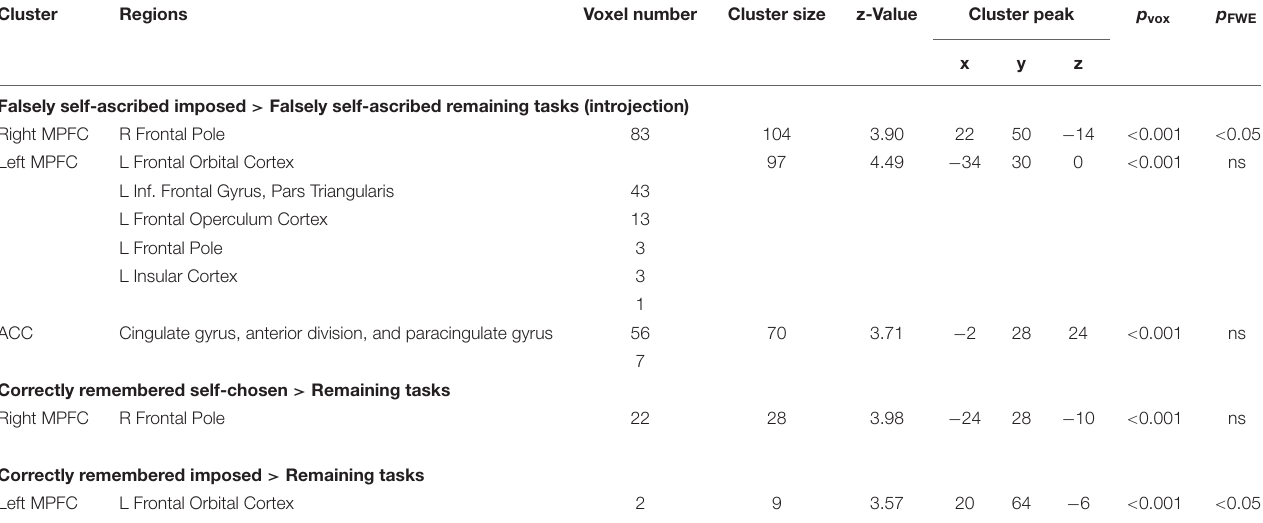
TABLE 1 | Regions showing BOLD signal changes. Cluster Regions Voxel number Cluster size z-Value Cluster peak p vox